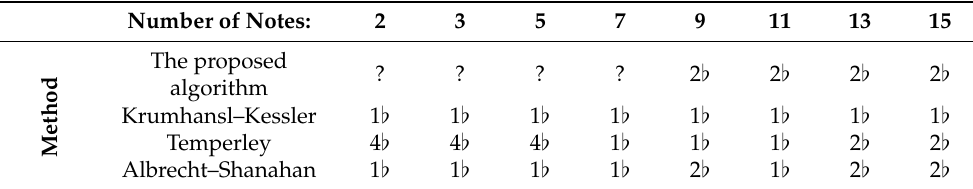
Table 4. Results of the key signature recognition using the proposed algorithm and the well-known algorithms based on tonal profiles, obtained for the fragment of F. Chopin’s Prelude 21, Op. 28 (Figure